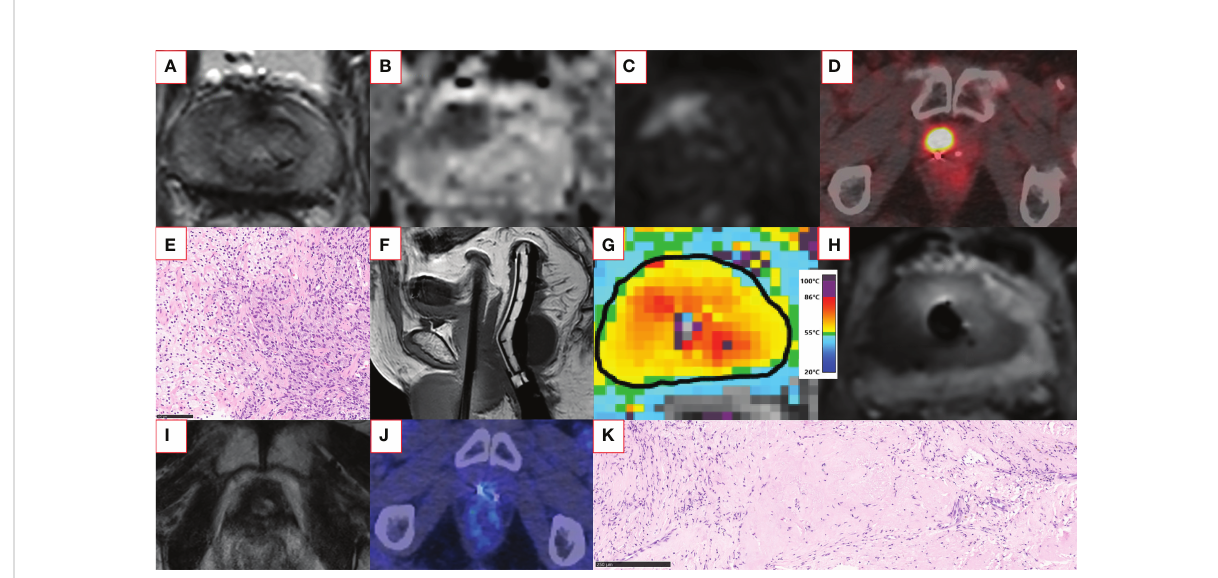
FIGURE 2 An example of a successful salvage TULSA patient case. The patient had a rising PSA of up to 13 ng/ml within six years after primary external beam radiotherapy. Screening T2-weighted (A) and diffusion-weighted (B) MRI showed a distinct anterior lesion with early enhancement on gadolinium-enhanced imaging (C) graded as PI-RR 5 lesion. The same lesion was also clearly visible in 18 F-PSMA-1007 PET-CT (maximum standardized uptake value 23) (D) . Two residual gold fi ducial markers implanted before image-guided radiotherapy are also visible next to the PSMA-positive lesion (D) . The MRI-targeted biopsy from the lesion revealed vital carcinoma resembling ISUP GG 5 disease (E) . The patient underwent whole-gland TULSA. On the sagittal T1-weighted image (F) , a transurethrally inserted ultrasound applicator, endorectal cooling device, and suprapubic catheter are in place. The targeted region reached a lethal minimum temperature of 55°C (G) . The non-perfused volume can be visualized immediately after treatment, demonstrating the acute ablation effect covering the targeted lesion (H) . At 12 months, the patient underwent follow-up imaging with multiparametric MRI and 18 F-PSMA-1007 PET-CT (I, J) , both negative for cancer. The prostate volume decreased from 20 cm 3 to less than 1 cm 3 at 12 months. The 12-month post-TULSA biopsy agreed with imaging fi ndings and showed only a treatment effect with no signs of cancer (K) . At the recent follow-up visit two years after TULSA, PSA is still low (PSA 0.067 ng/ml) and stable, and the patient has leak- and pad-free continence and erections suf fi cient for intercourse. The TULSA treatment report of